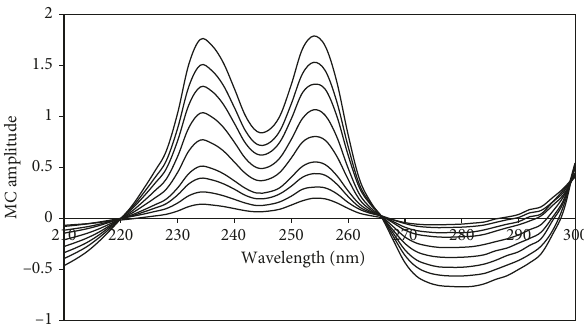
Figure 12: Mean-centered ratio spectra (0.5, 1, 1.5, 2, 3, 4, 5, 6, and 7 μ g · mL − 1 ) of chlorothalonil in methanol as a blank.